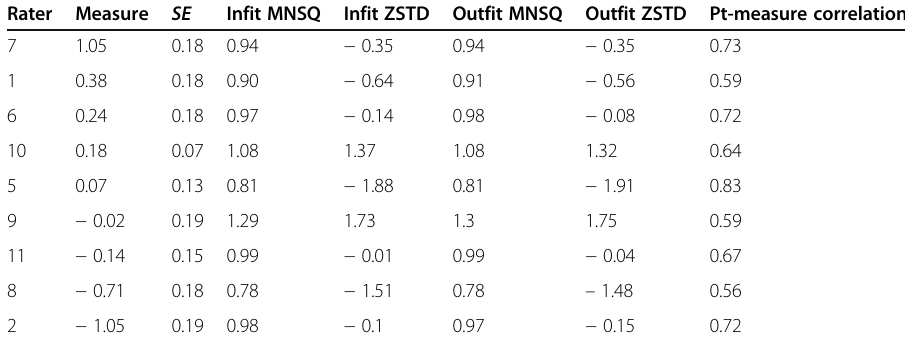
Table 3 Rasch statistics for the raters for the speaking assessment Rater Measure